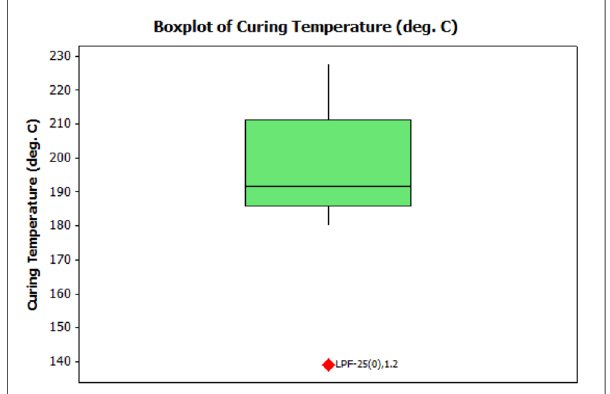
Figure 5. Box plot of curing temperature (°C).